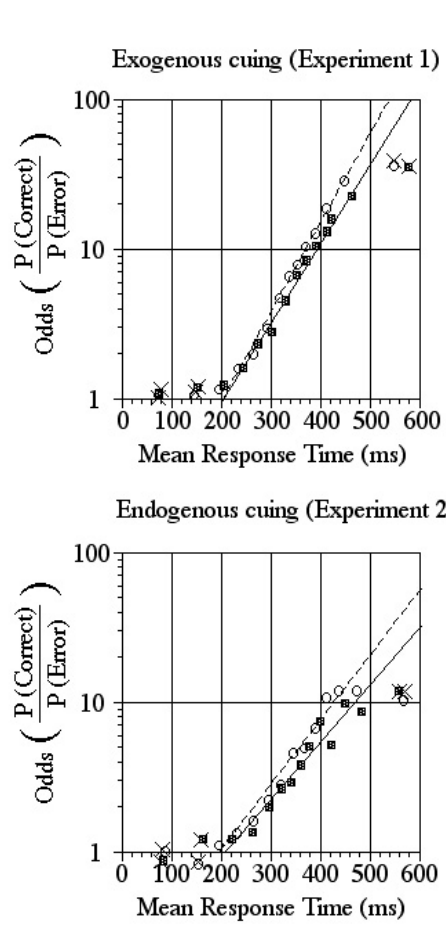
FIGURE 2. SAOCs for valid and invalid cues in Experiment 1 (exogenous cues) and Experiment 2 (endogenous cues). The data, trimmed across a range where a tradeoff occurred (symbols without a superimposed “X”), were fit by regressing the logarithm of the odds of making a correct response on the mean of the ranked RT interval data. Dashed lines and open circles represent valid cues, solid lines and closed squares represents invalid